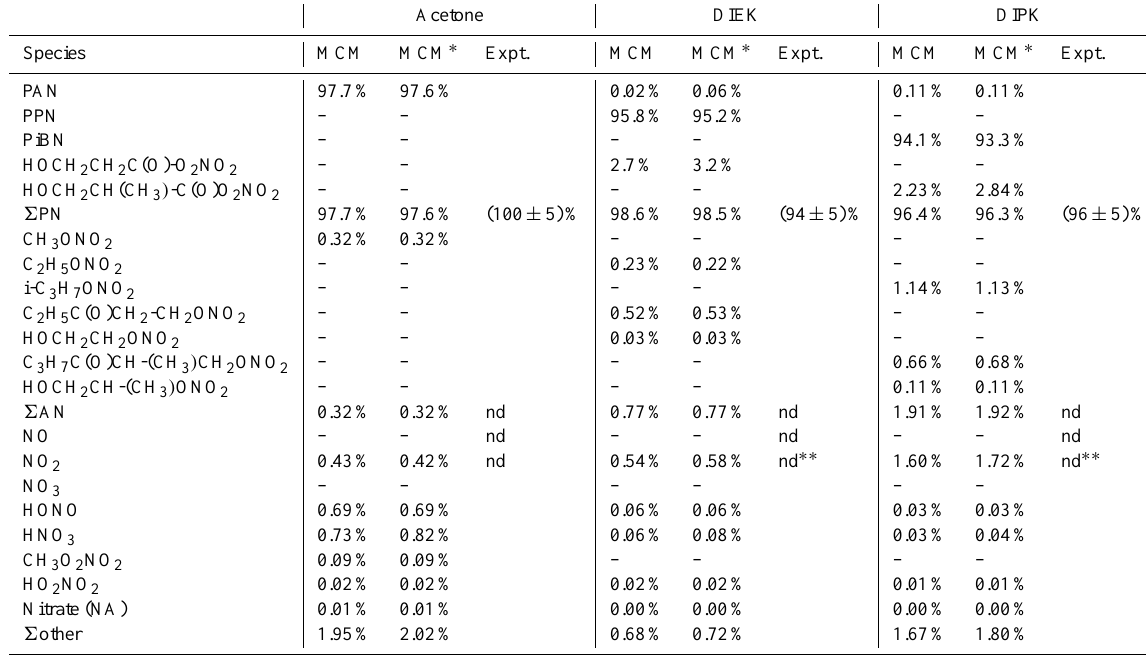
Table 1. Photo source product yields, relative to the amount of NO added, predicted by MCM box model simulations and observed. Species with an abundance of <5 × 10 − 6 relative to NO y are omitted. nd = below limit of